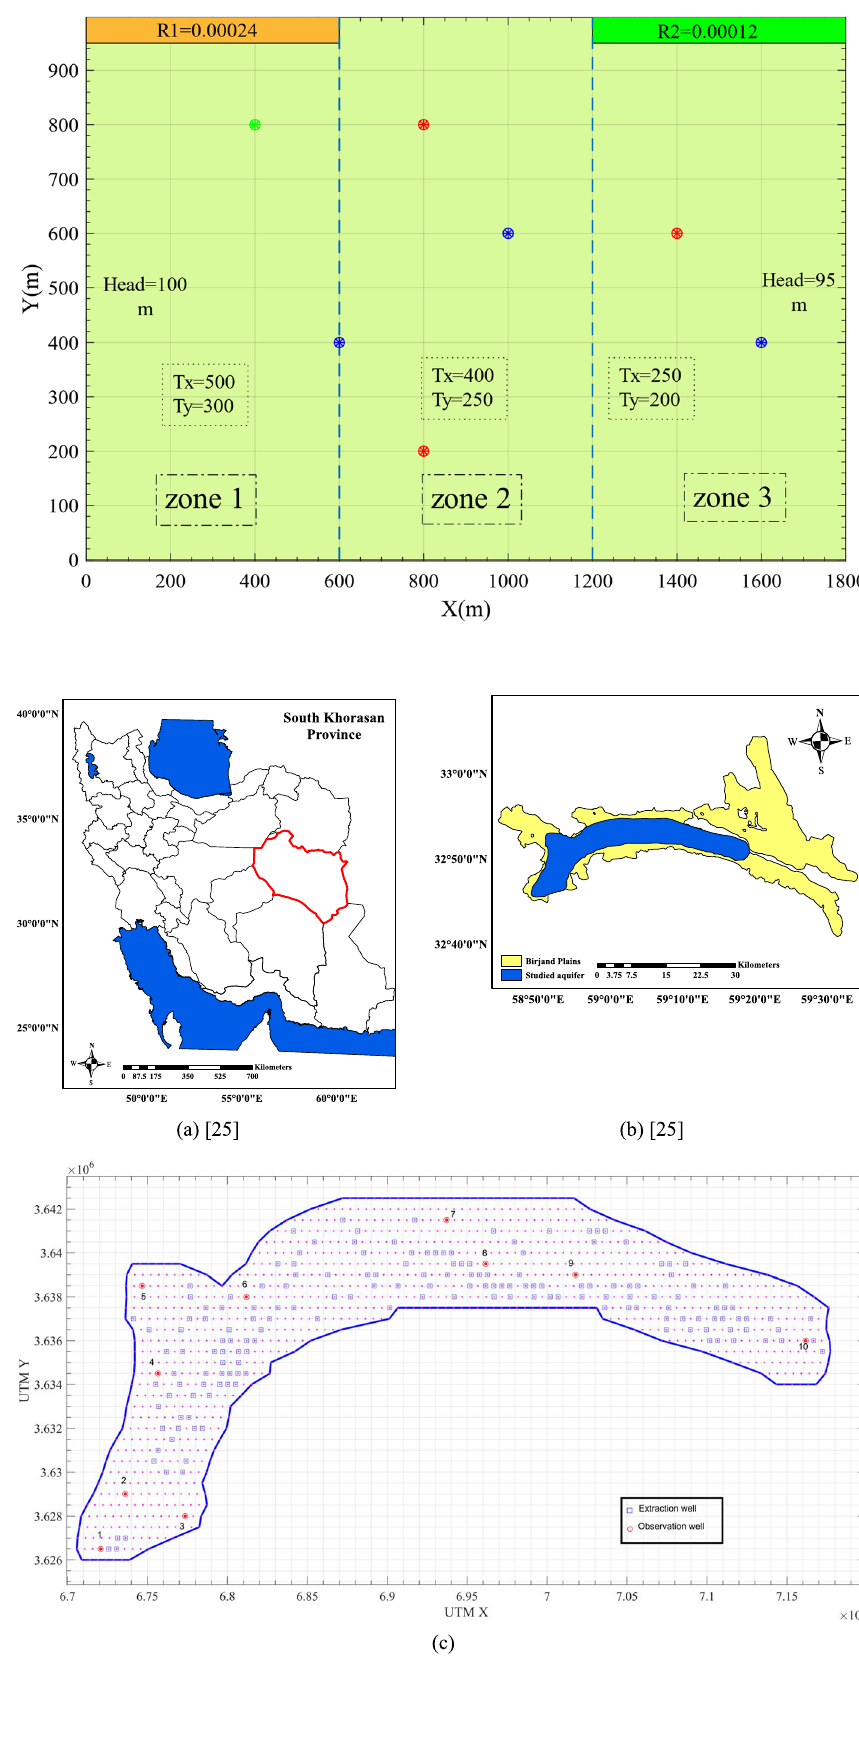
Fig. 2 Representation of 2-dimensional of standard aquifer